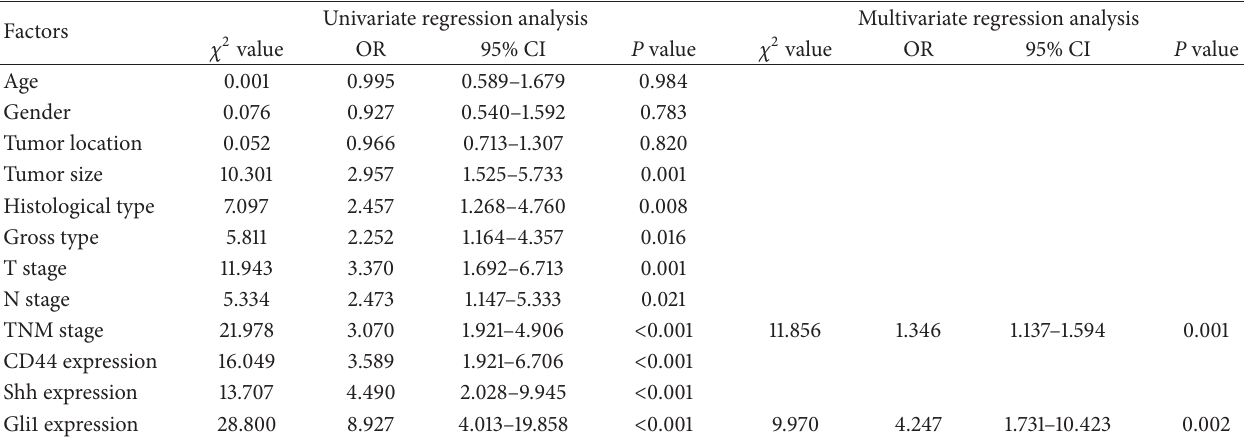
Table 2: Univariate and multivariate analysis for overall survival in gastric cancer after radical resection.